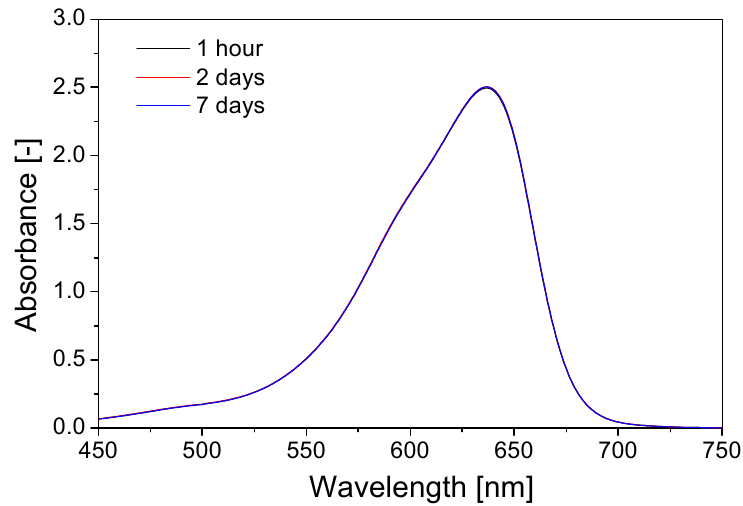
Figure 6. The stability of the gel ‐ hydrogel solution (60 μ M TBO, 5% H 2 O 2 , 25% Pluronic F–127) kept in a fridge. The samples were irradiated with 0.7 J/cm2 of UVB radiation and measured 1, 48 and 168 h after gel ‐ hydrogel preparation.